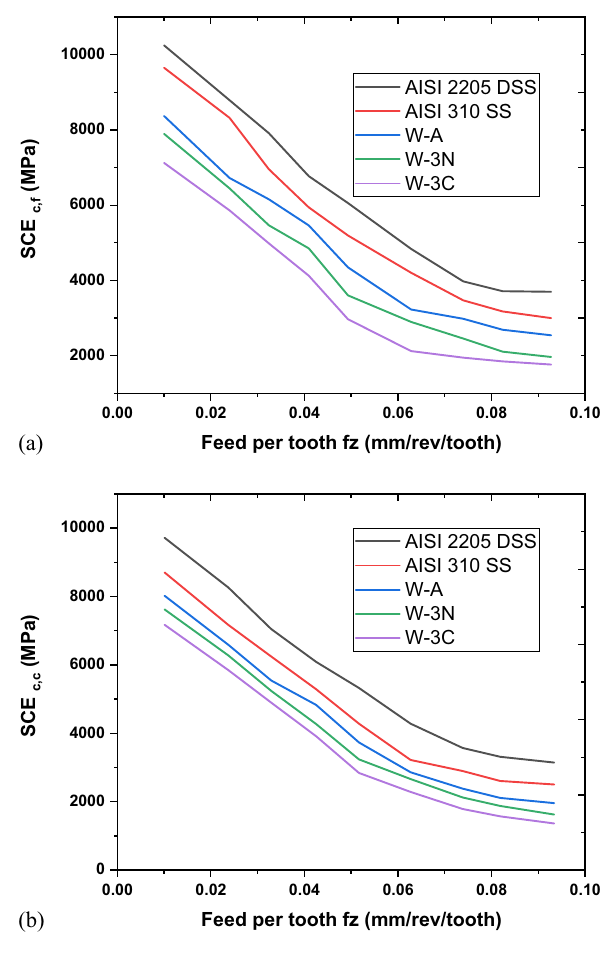
Figure 9: Speci fi c cutting force in ( a ) feed direction and ( b ) cutting